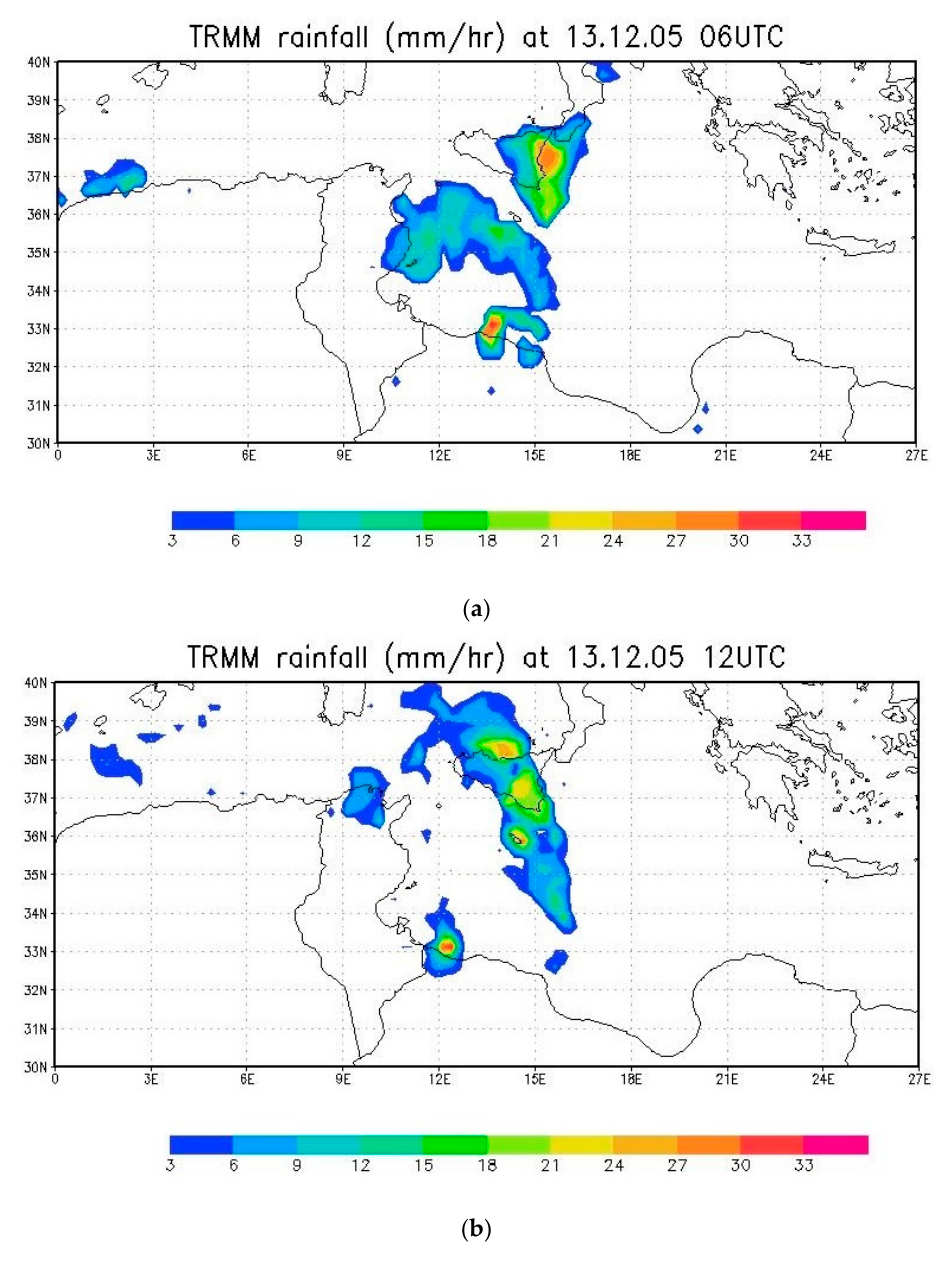
Figure 4. TRMM hourly rainfall rate (mm h − 1 ) from ( a ) 13 December 2005 06:00 UTC and ( b ) 13 December 2005 12:00 UTC [22].